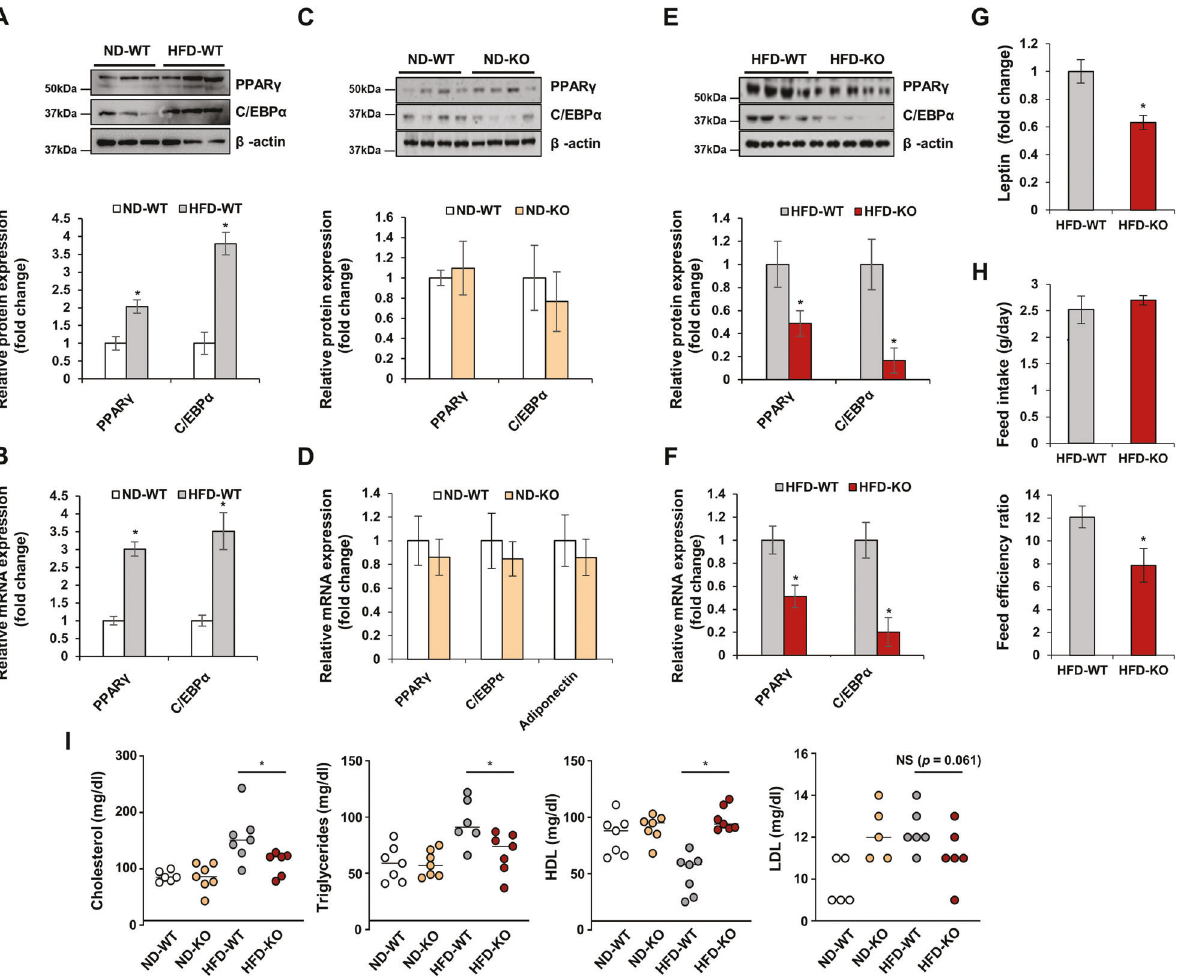
G Relative plasma leptin levels of the HFD-fed WT and KO mice. H Feed intake was calculated using the following formula: total feed intake (entire experimental period)/days (entire experimental period, 83 days). The feed ef fi ciency ratio was calculated using the following formula: body weight gain (g)/amount of feed provided (g) × 100. i Plasma cholesterol, TG, HDL (high-density lipoprotein), and LDL (low-density lipoprotein) were determined in the ND-fed or HFD-fed WT and KO mice. Error bars represent the mean ± SEM. * p < 0.05 by two-sided t